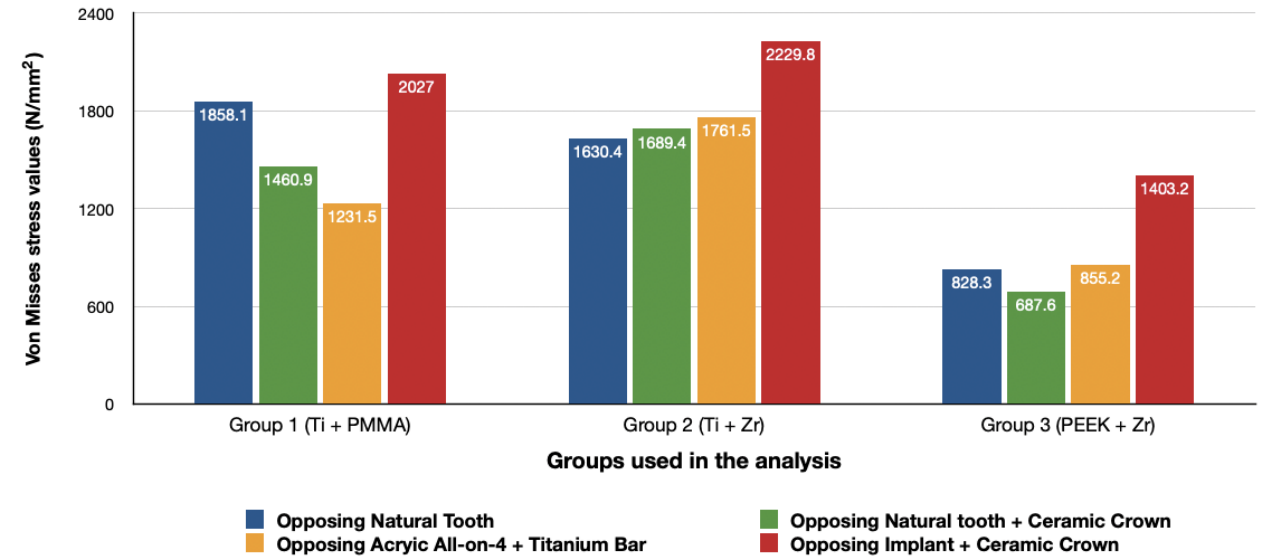
Figure 12. Von Mises stress values on posterior implants under loads.